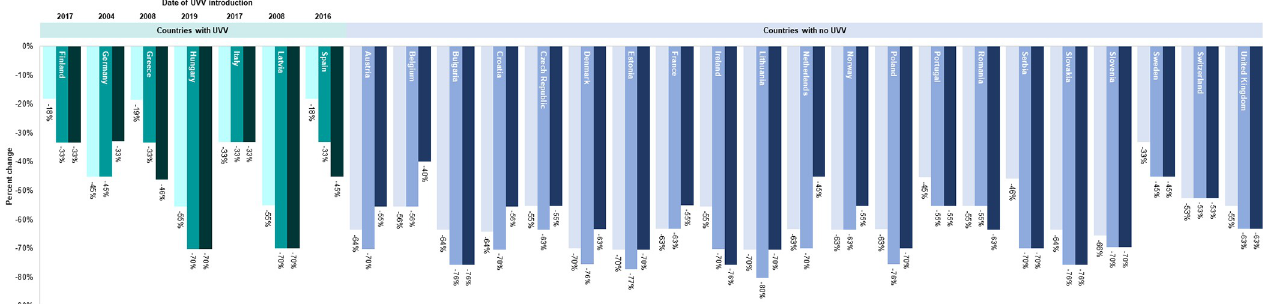
Fig 5. Percentage change in absolute search query volume from March 2020, the start of the COVID-19 pandemic, to April, May, and June 2020. Bars represents the percent decline in search query volume from March to April 2020 (lightest bar), March to May 2020 (medium bar), and March to June 2020 (darkest